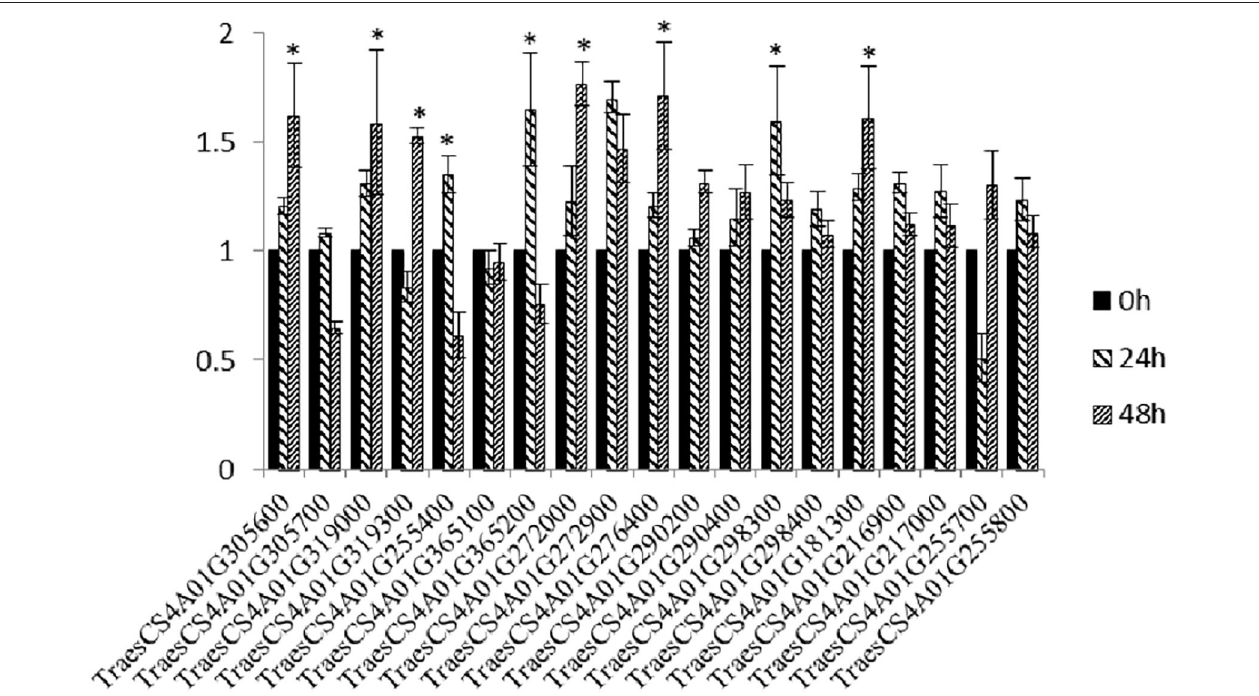
FIGURE 2 | Relative expression levels of 19 candidate genes at 24 and 48h in M8664-3 after inoculation with Pst race CYR33. The data were normalized to the wheat TaEF-1 α gene. Wheat leaves treated with distilled water were included as a control. Error bars represent the standard deviations of three independent samples. The significance of differences is indicated by asterisks and tested using Student’s t -test ( P < 0.05).